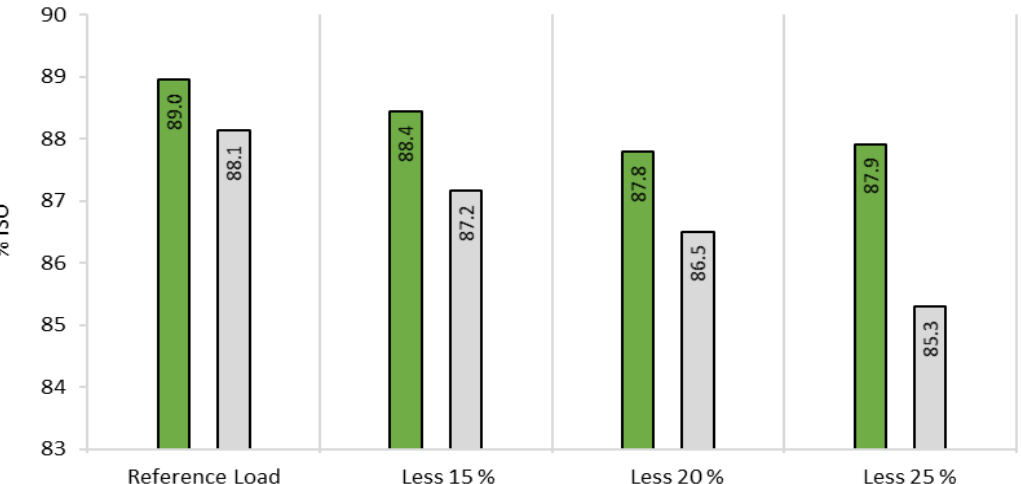
Figure 3. Final pulp brightness (after D 2 ) obtained after 5 h prebleaching stage with Xyn11 (green) followed by bleaching with reference ClO 2 load or with 15%, 20% or 25% less ClO 2 in each D step, compared with the corresponding controls (grey).